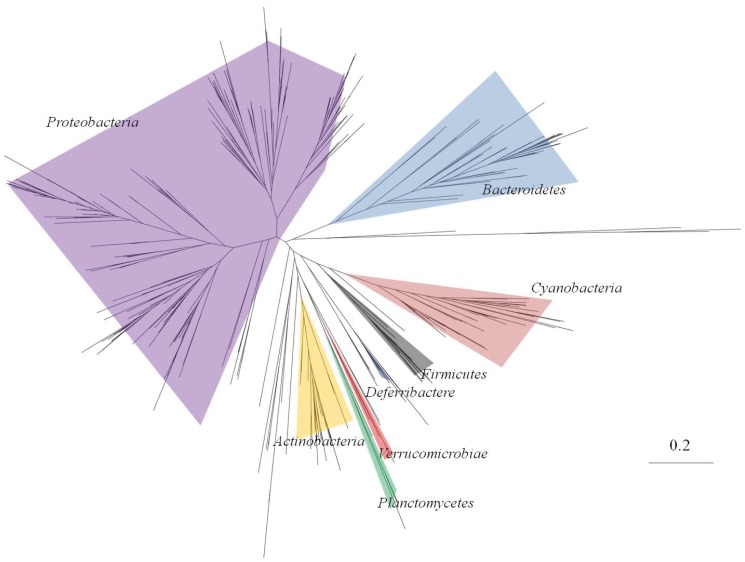
Maximum likelihood phylogenetic radual tree generated by 170 OTUs assembled of 2443 sequences derived from 31 bacterial clone libraries.The detailed polar tree was shown in Figure S3.